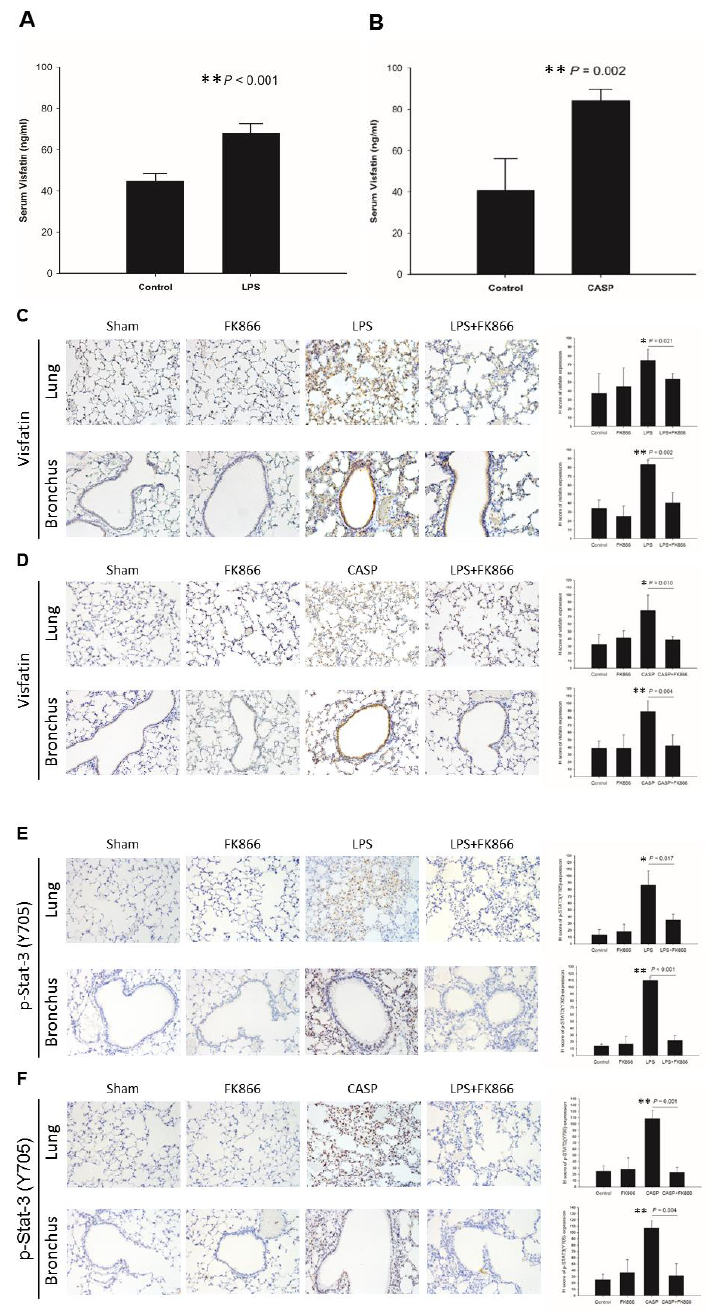
Figure 2. FK866, a visfatin inhibitor, decreased acute lung injury and increased survival in LPS and CASP ALI mouse models. ( A and B ) Histology of lung tissues in mice treated with LPS alone, CASP alone, or co-treatment with FK866, determined by H&E staining. Sham mice show normal lung tissue and LPS- or CASP-treated mice show injuries in lung tissue, including fluid-filled alveoli, septal thickening, and interstitial lymphocytic and neutrophilic infiltration. (100× amplification). ( C and D ) Survival rate in mice treated with LPS alone, CASP alone ( n = 15), or co-treatment with FK866 ( n = 15) in ALI mouse model. *, p value < 0.05. **, p value <